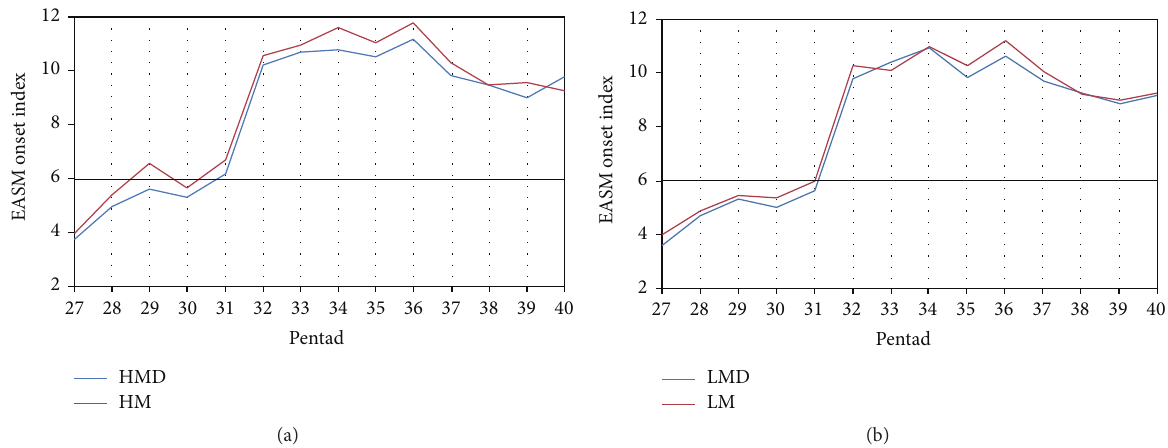
Figure 12: East Asia summer monsoon onset index averaged in the southern monsoon region (22 ∘ –30 ∘ N, 105 ∘ –120 ∘ E) in (a) HMD and HM and (b) LMD and LM.